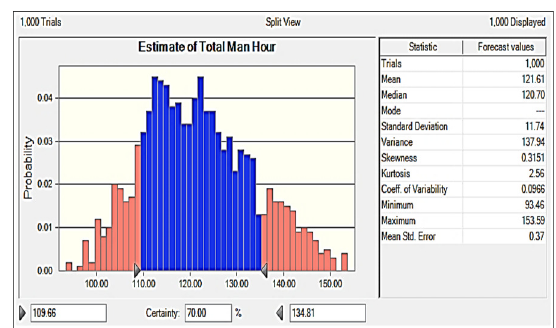
Fig. 7: Estimate of Total Man Hours at 85%